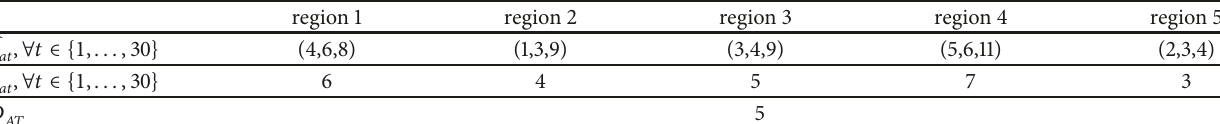
Table 2: The supply of materials during the past period of time the public observe.